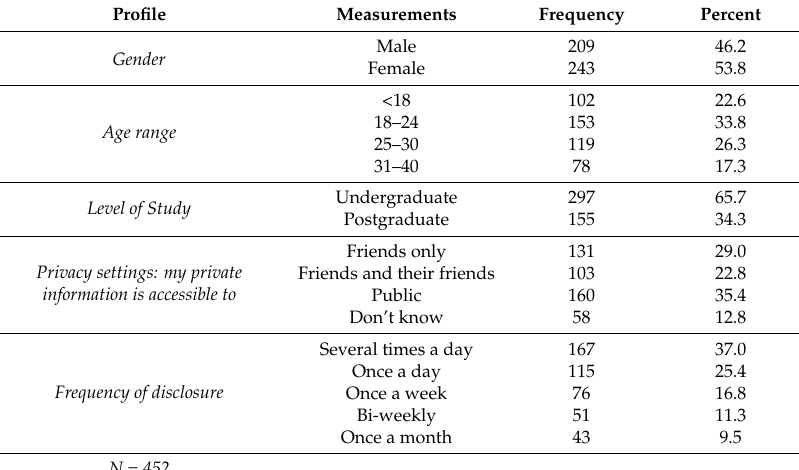
Table 1. Profile of